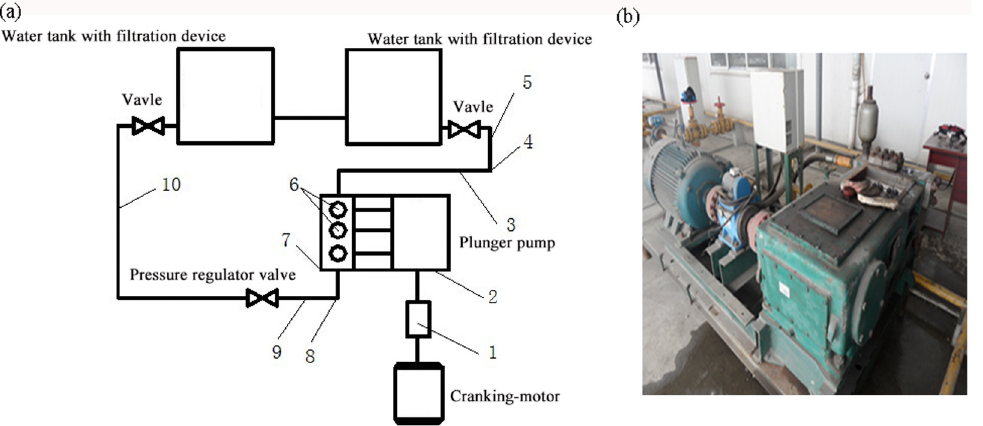
Fig 9. Test principle diagram of valve motion. 1) Torque speed sensor; 2) angular displacement sensor; 3) inhalation flow sensor; 4) temperature sensor; 5) pressure sensor; 6) displacement sensor; 7) vibration sensor; 8) discharge pressure sensor; 9) discharge flow sensor; 10) temperature